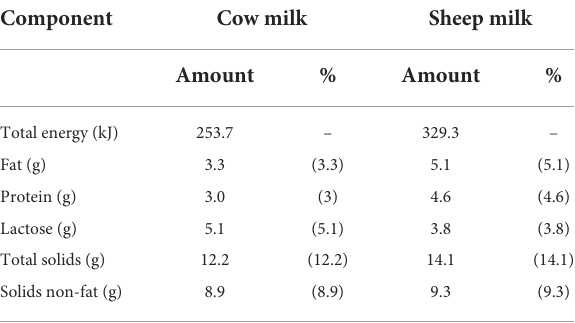
TABLE 1 Proximate composition per 100mL of the sheep and cow milk test drinks. Component Cow milk Sheep